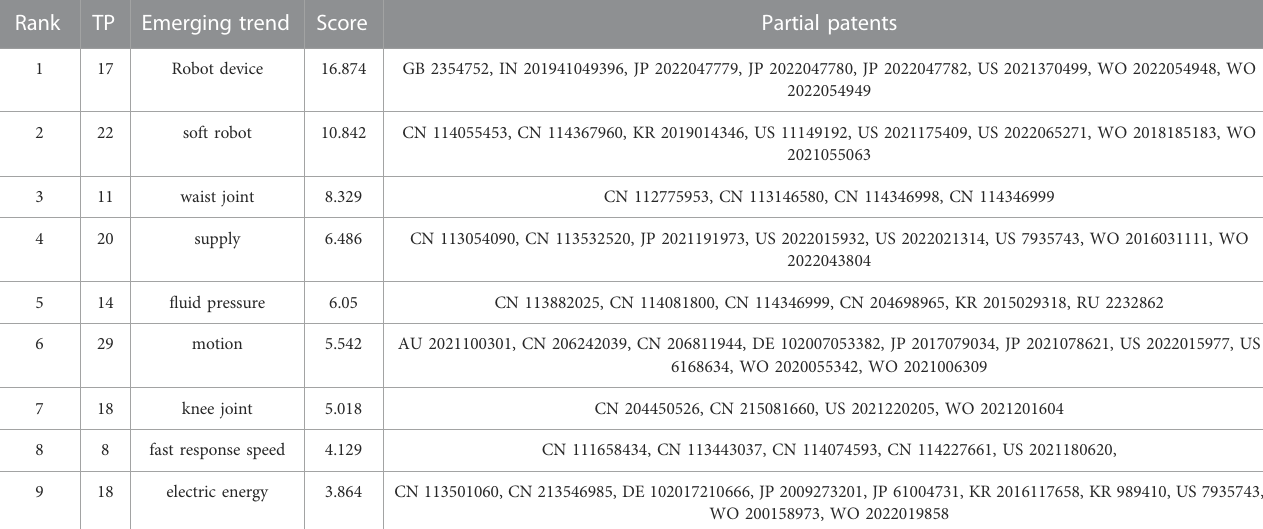
TABLE 6 Emerging trends of arti fi cial muscle